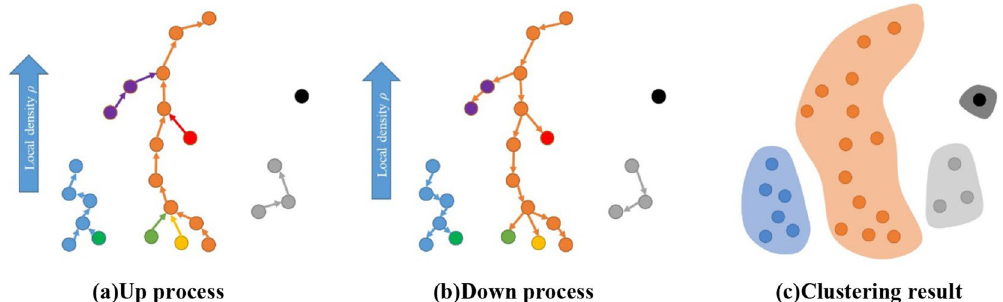
Figure 1. Bidirectional clustering algorithm based on local density. ( a ) Up process. Starting from the data point with minimum local density ( q i ), the data points q j whose local density is greater than ρ i and closest to the q i point must be searched for. The search operation is repeated until there is no data point with a larger local density within the cutoff distance d c to form a data chain from q 1 to q m . When the same calculation is done for the remaining data, the data chains of all data points are finally obtained. ( b ) Down process. The clustering operation is finally completed by sorting out the data chains formed in the up process, classifying those data chains by their top data points, merging them, and then traversing all the points in the dataset, as shown in ( c ) clustering